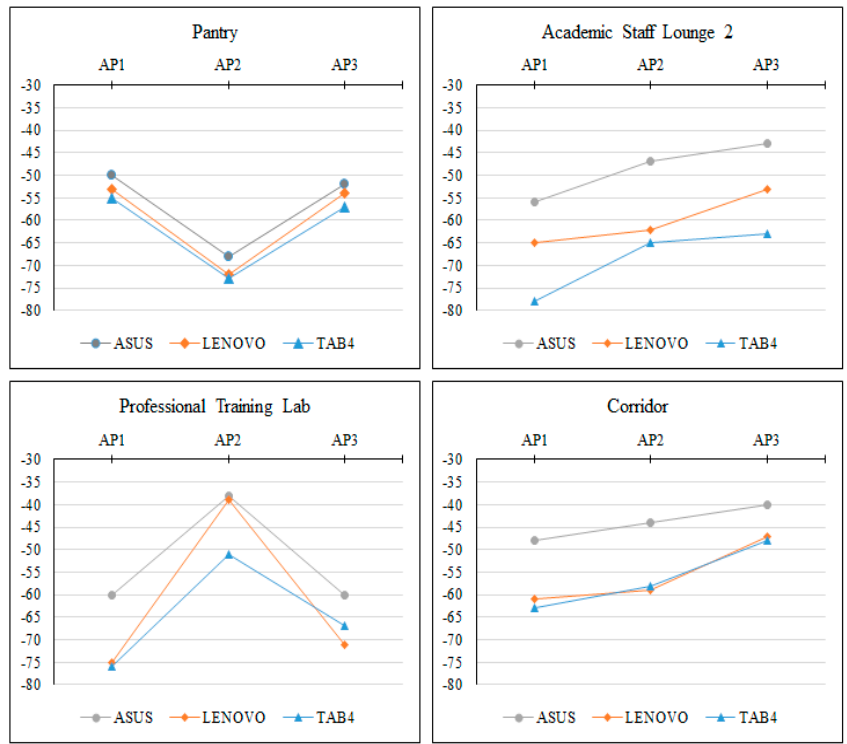
Figure 16. The calibrated RSS differences over four different reference points.